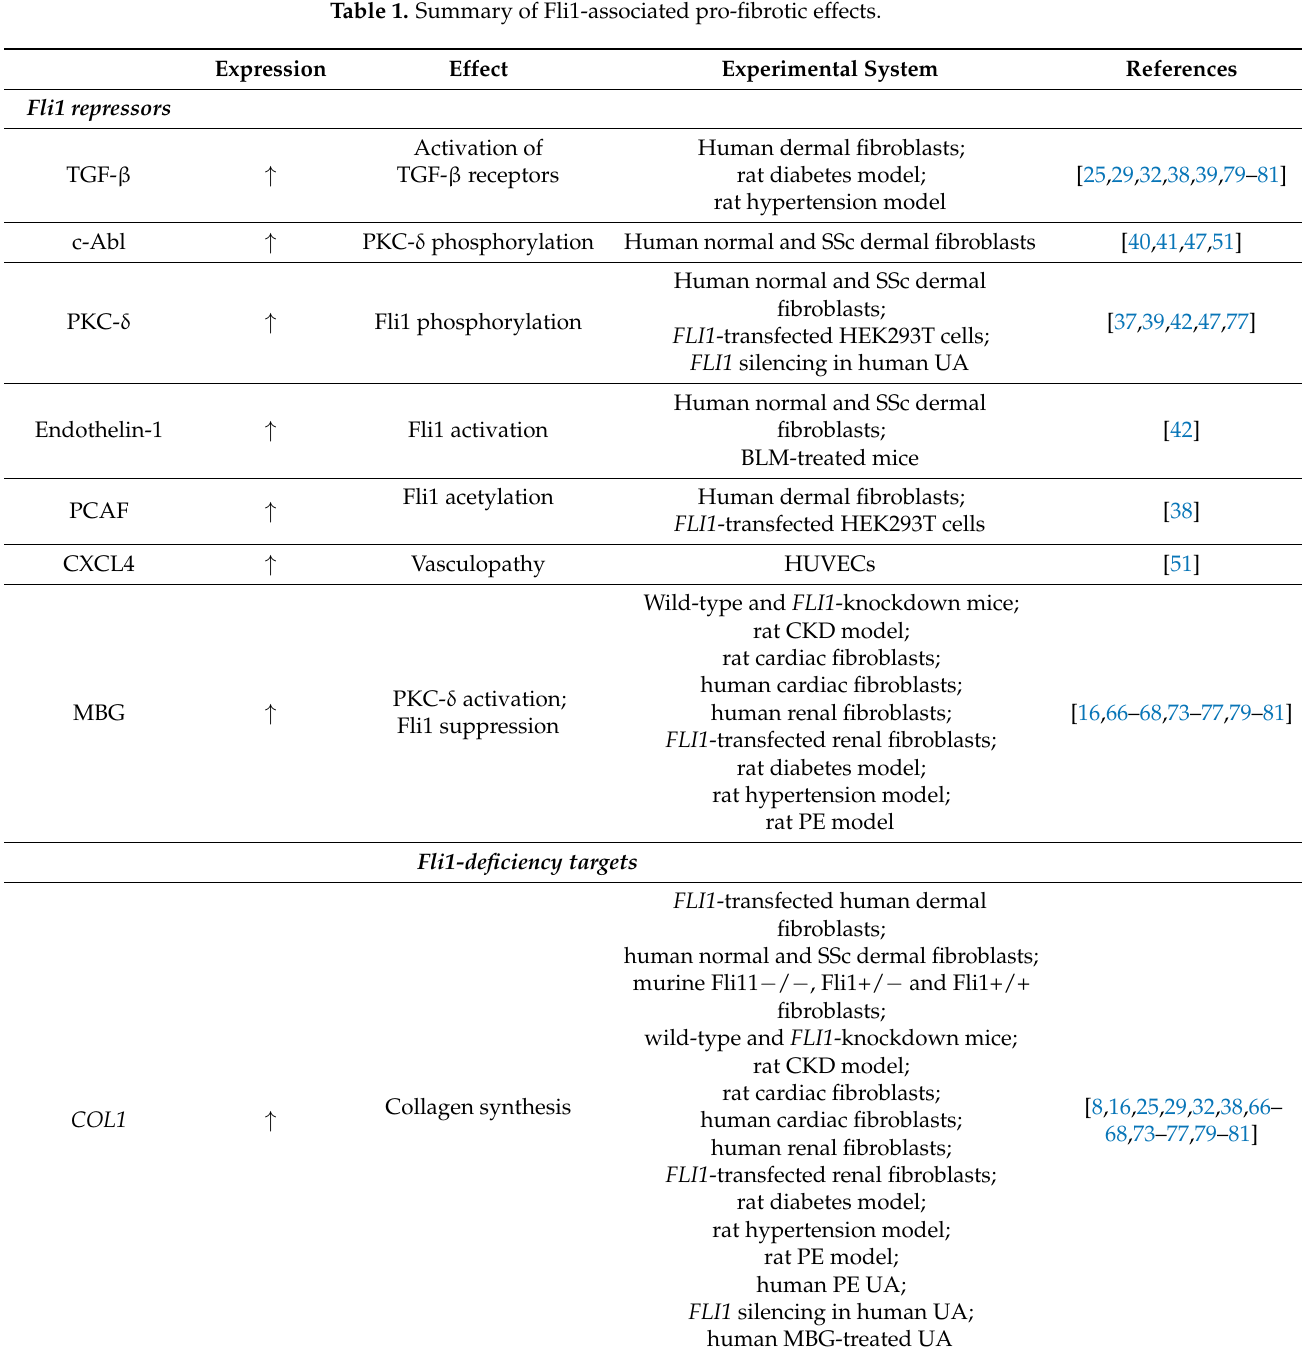
Table 1. Summary of Fli1-associated pro-fibrotic